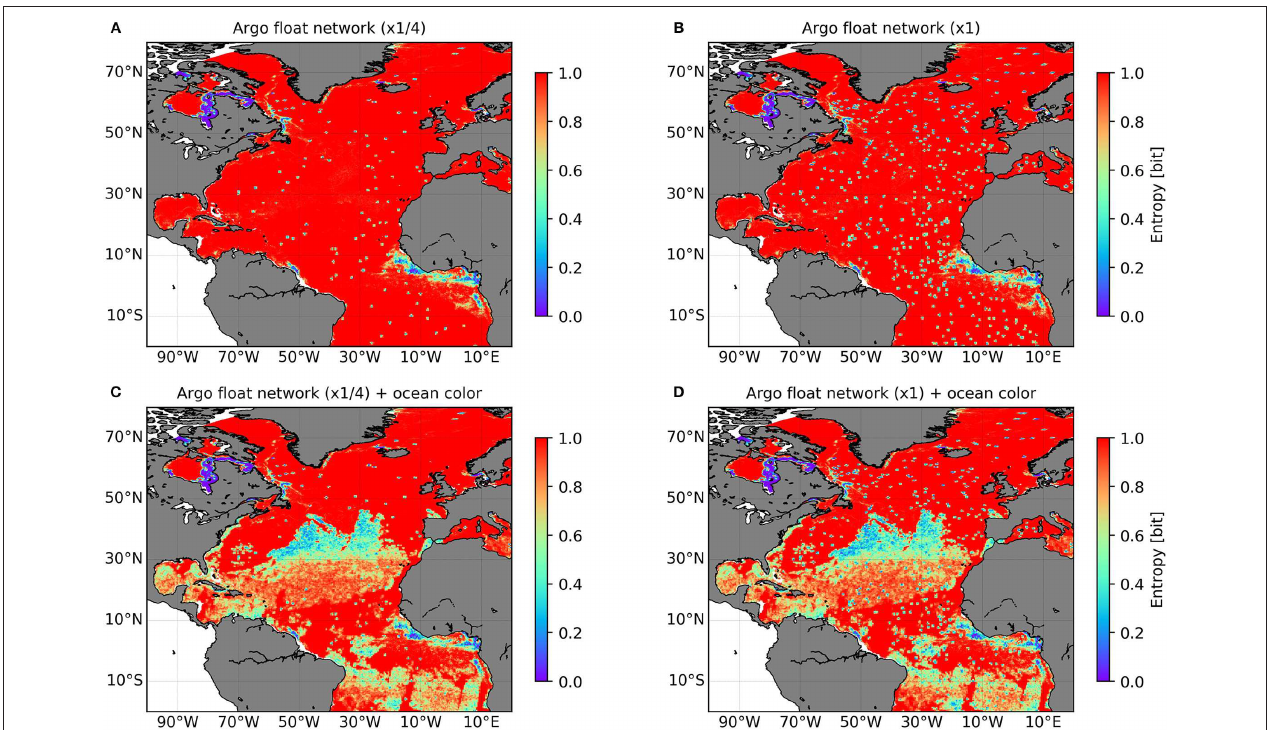
FIGURE 12 | Result of the OSSE studies for the future deployment scenarios of BGC Argo floats in H2020 AtlantOS. Showing entropy skill score related to the chlorophyll distribution at 24m in the scenarios of (A) BGC-Argo sensors on 1/4 of the nominal Argo array, (B) BGC-Argo sensors on the full nominal Argo array, (C) daily satellite ocean color data and BGC-Argo on 1/4 of the nominal array, and (D) daily satellite ocean color data and BGC-Argo on nominal array. Note that reducing prior uncertainty of the system is having entropy values lower than 1 (red) and > 0 (blue), with respect to a set of probabilistic events that are relevant to compare the different scenarios.